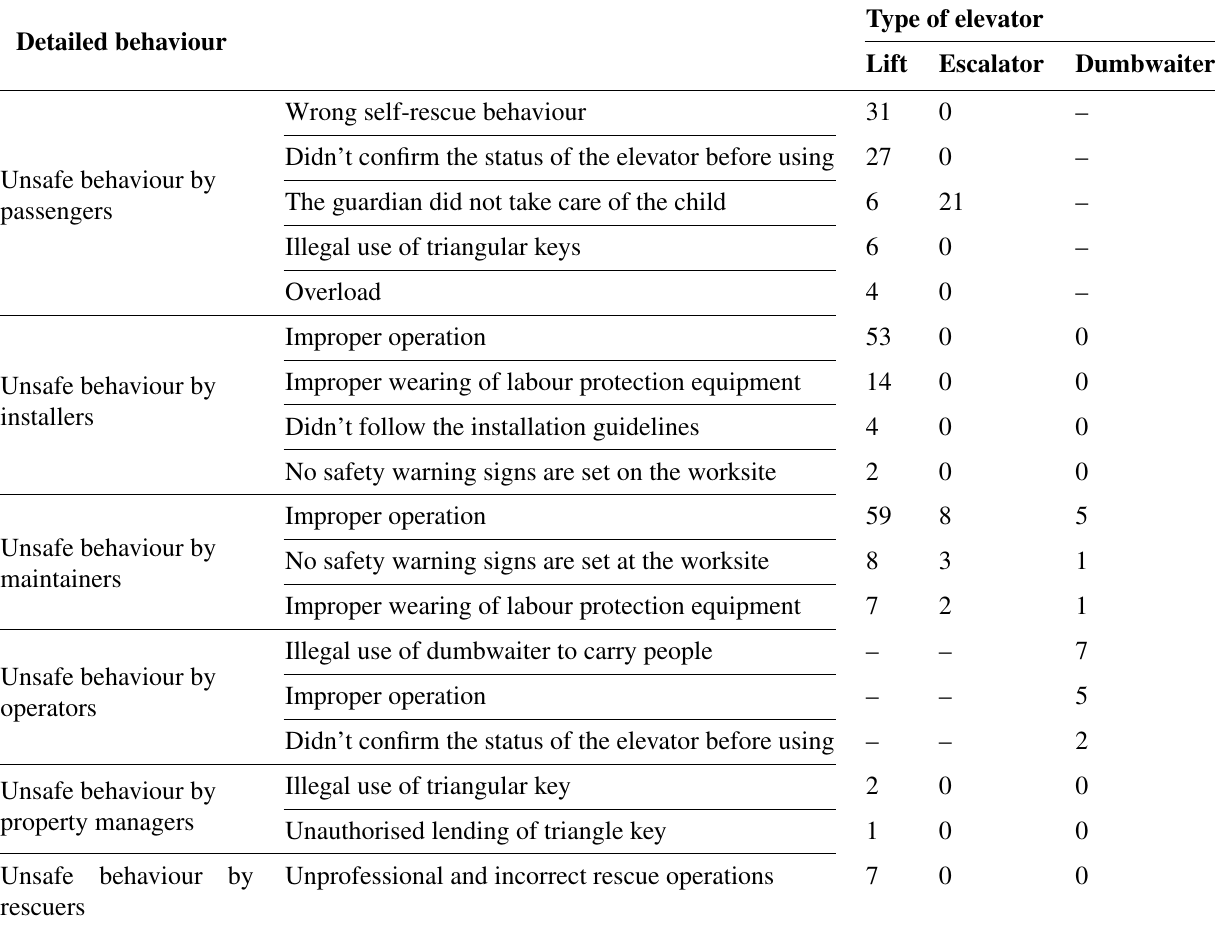
Table 5 Unsafe behaviour